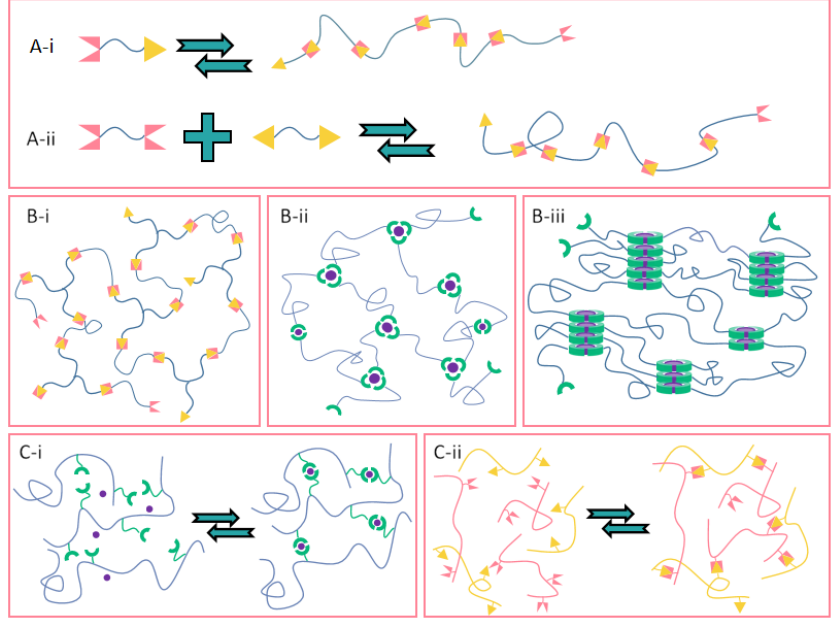
Figure 4. Different Design Strategies of Supramolecular Polymer Networks. ( A-i ) Linear supramolecules are linked by homogenous complementary motifs. ( A-ii ) Linear supramolecules are linked by heterocomplementary motifs. ( B-i ) Supramolecular networks are cross-linked in a bivalent manner through triplet components. ( B-ii ) Supramolecular networks are cross-linked by associative linear nodes with a functionality higher than two. ( B-iii ) Supramolecular networks are cross-linked by the lateral stacking or aggregation of dynamic cross-linking points. ( C-i ) Side chain supramolecular polymers are cross-linked by a low molecular weight cross-linker. ( C-ii ) Side-chain polymers chains cross-linked by mutual heterocomplementary polymer–polymer